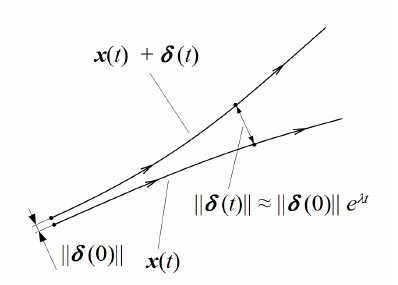
Figure 2. A path of a neighbouring pair of states in the phase space